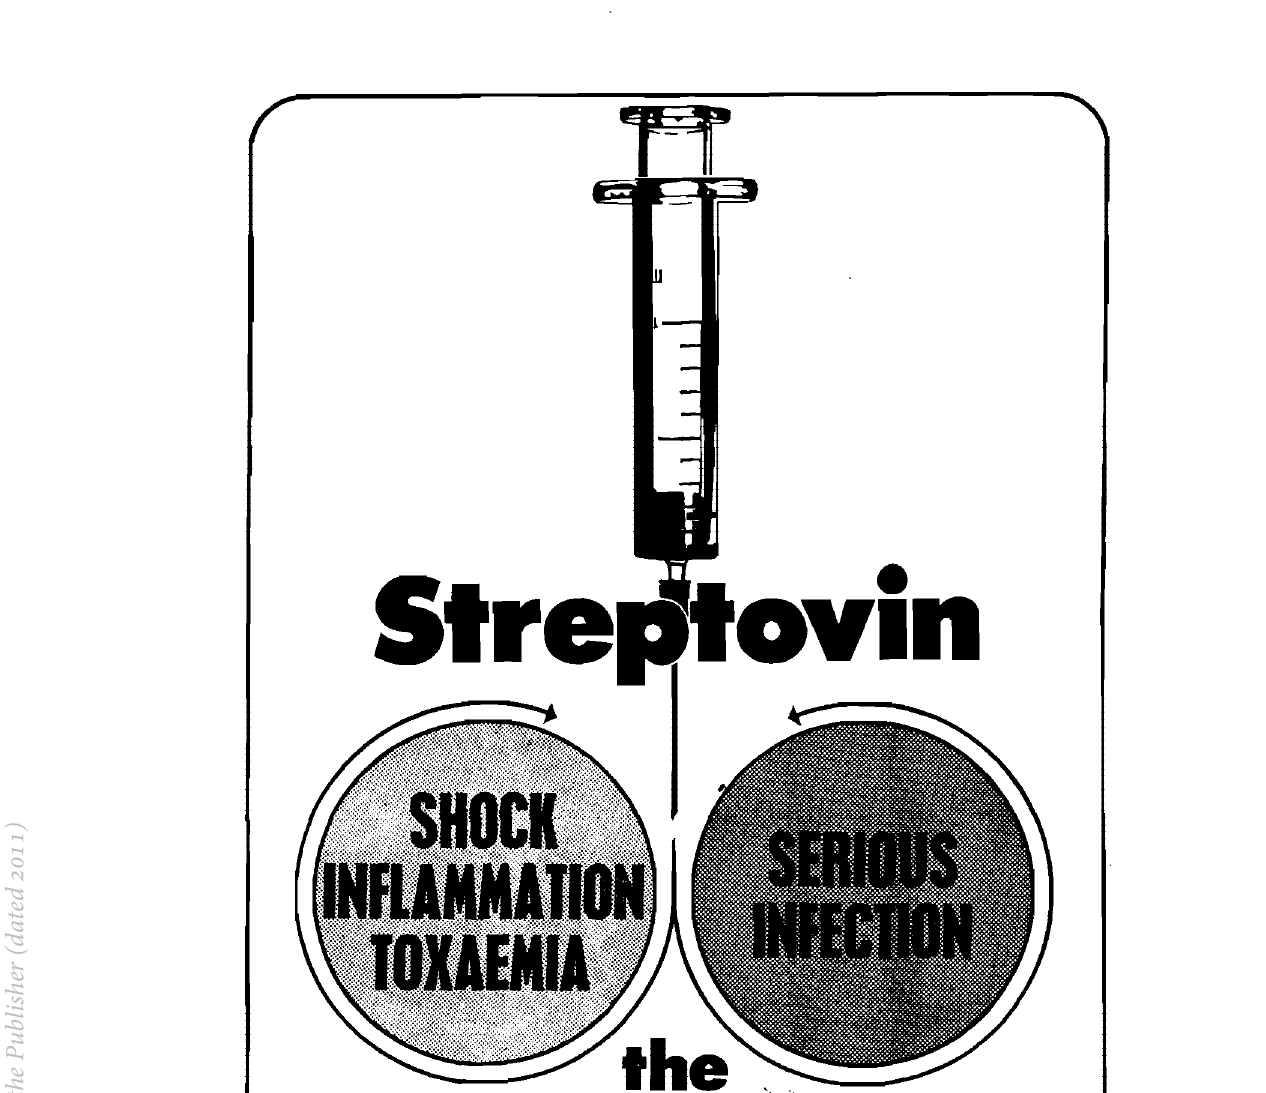
Streptovin controls both infection and inflammation in a single ready-to-use injectable preparation. The quantity of steroid and antibiotics in Streptovin has been carefully predetermined to elicit the optimum response in most cases. It also helps the animal to resist the bacterial toxins which can spread systemically and to counter the circulatory collapse which can otherwise follow. Some